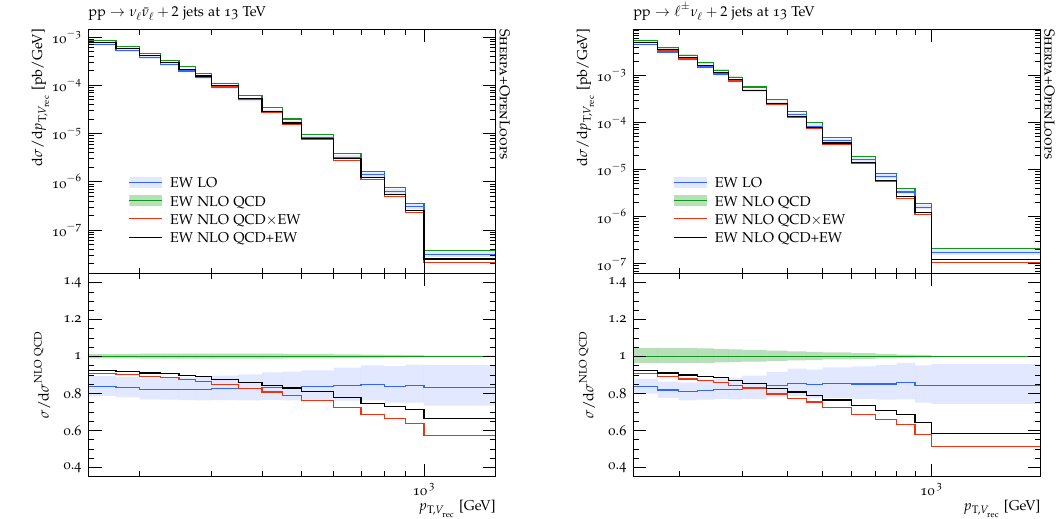
Figure 6. Distribution in the reconstructed transverse momentum of the off-shell vector boson, p T , V , for EW pp → Z ( ν ‘ ¯ ν ‘ ) + 2 jets (left) and EW pp → W ± ( ‘ ± ν ‘ ) + 2 jets (right). Absolute EW LO (blue), NLO QCD (green), NLO QCD+EW (black) and NLO QCD × EW (red) predictions are shown in the upper panel. Here NLO QCD and NLO EW corrections should be understood as O ( α s ) and O ( α ) effects w.r.t. to the EW LO. The same predictions normalised to NLO QCD are shown in the lower panel. The bands correspond to QCD scale variations, and in the case of ratios only the numerator is